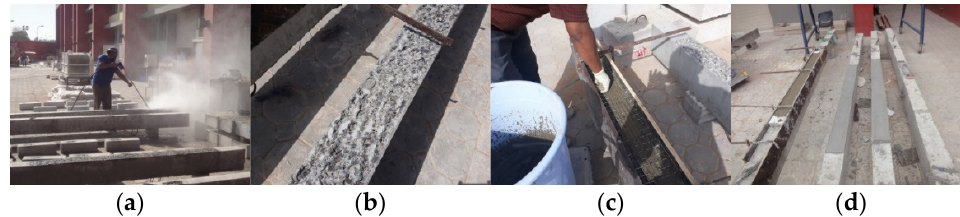
Figure 5. Strengthening procedure: ( a ) water jetting; ( b ) roughened surface; ( c ) application of FRCM; ( d ) finished surface.